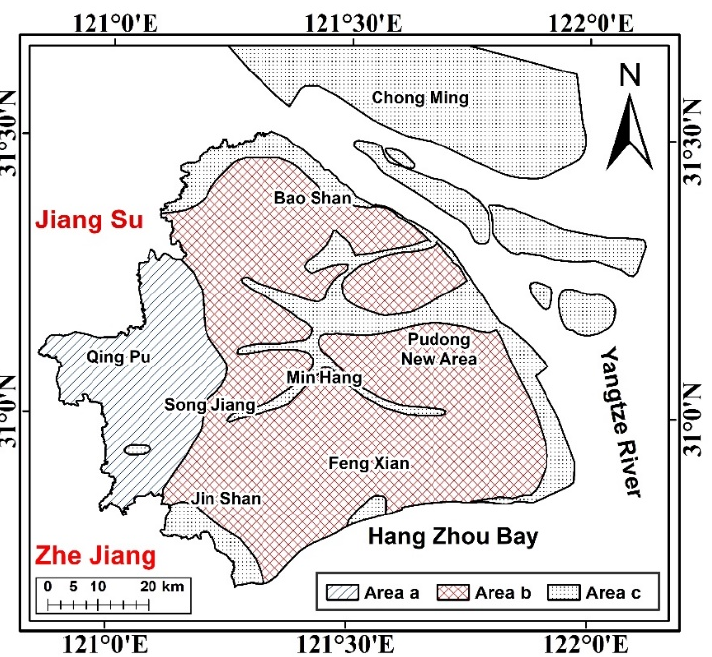
Figure 12. Geological type distribution map (Area a—solid and stable foundation; area b—relatively stable foundation; Area c—foundation with poor stability).